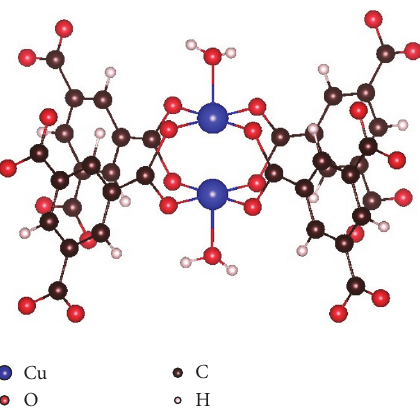
Figure 1: Schematic representation of the paddle-wheel unit of as synthesized HKUST-1. Each Cu 2+ ion is coordinated with four carboxylate groups, belonging to four 1,3,5-benzene tricarboxylate (BTC) linker molecules and one water